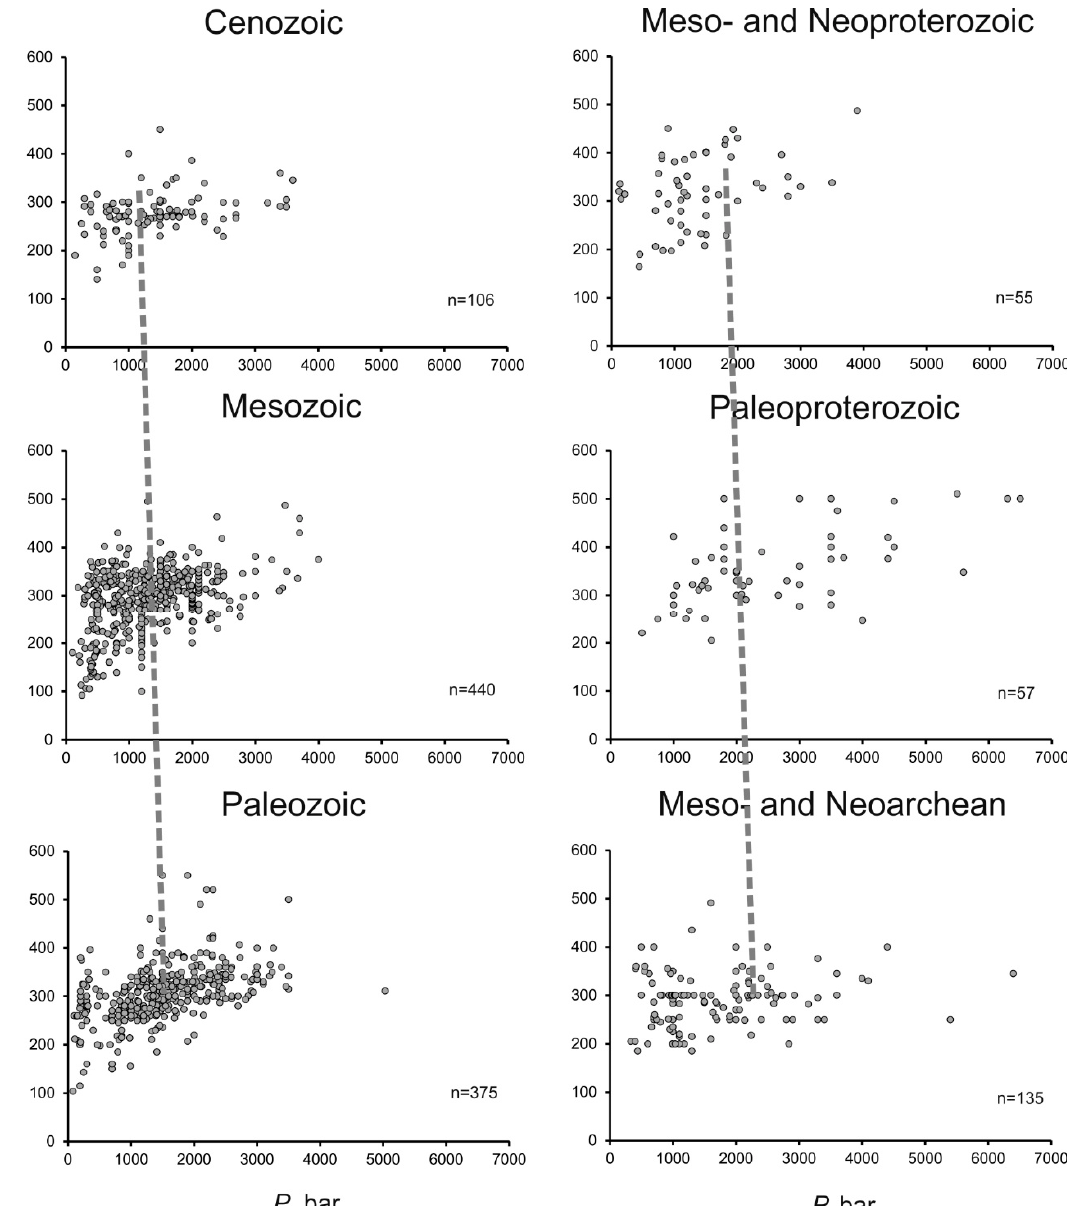
Figure 2. Temperature–pressure diagrams for mineralizing fluids at gold deposits of different age.